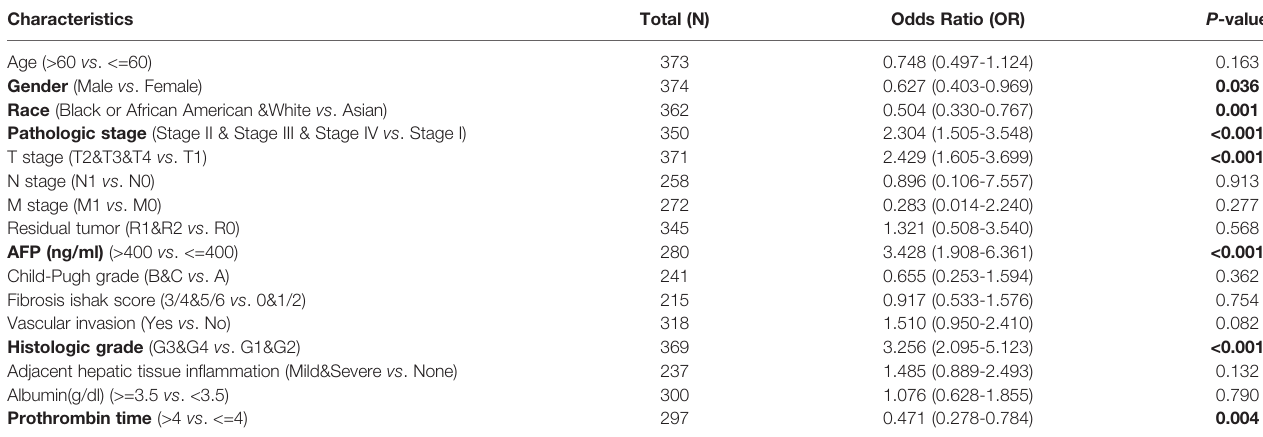
TABLE 1 | Logistic analysis of the association between CDT1 expression and clinical characteristics in HCC patients. Characteristics